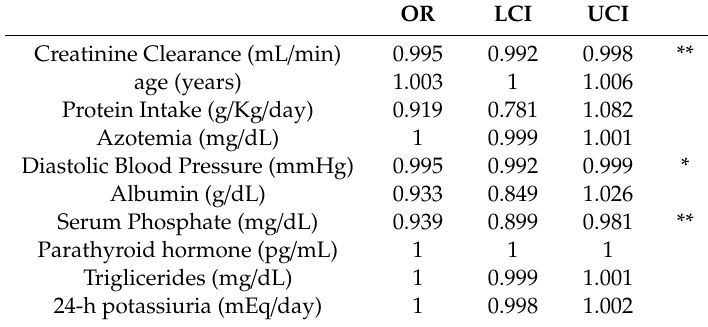
Table 3. predictors of abnormal Fractional Excretion of Phosphate ( > 20%) at logistic regression analysis. Table legend: OR: odds ratio; LCI: lower bounder of 95% confidence interval; UCI: upper bounder of 95% confidence